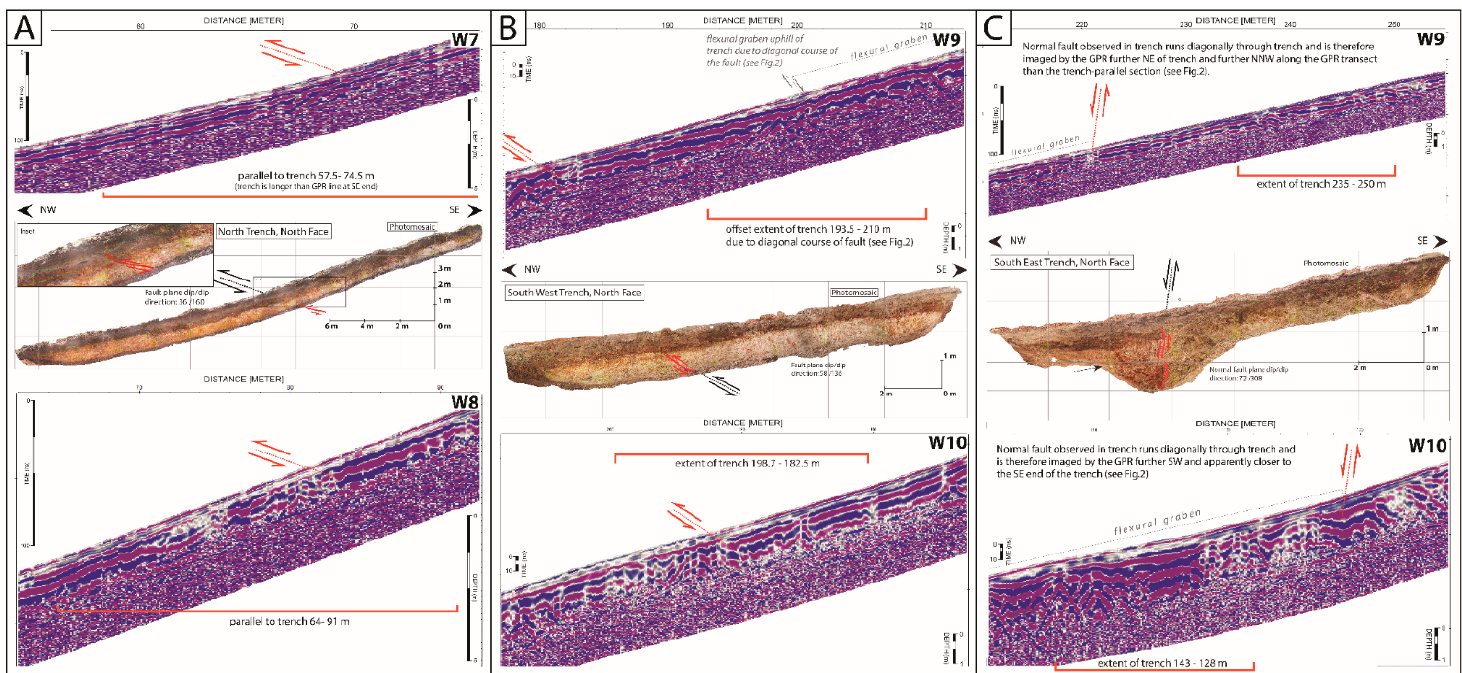
Figure 4. Correlation of trench logs from the 2018 trenching campaign with relevant GPR data. Red fault movement indicators in the photomosaics of the trenches are adapted from [18]. Black fault movement indicators were added for clarification. The red fault movement indicators in the GPR panels mark the locations of the identified fault traces within the GPR data. Light grey annotations in the GPR data indicate other features identified proximate to the ‘main’ feature (for full interpretations of the GPR transect see the Supplementary Material). ( A ) Trench (1): The reverse fault observed in the northern trench of the 2018 campaign is clearly imaged in both adjacent GPR transects by a change from mostly undisrupted reflectors on the hanging wall to thickening, disrupted reflectors on the footwall. The Heatherdale Shale, i.e., the light brown-yellowish bedrock imaged in the trenchlog, correlates with the ‘grainy’ texture of the GPR data at depth. ( B )